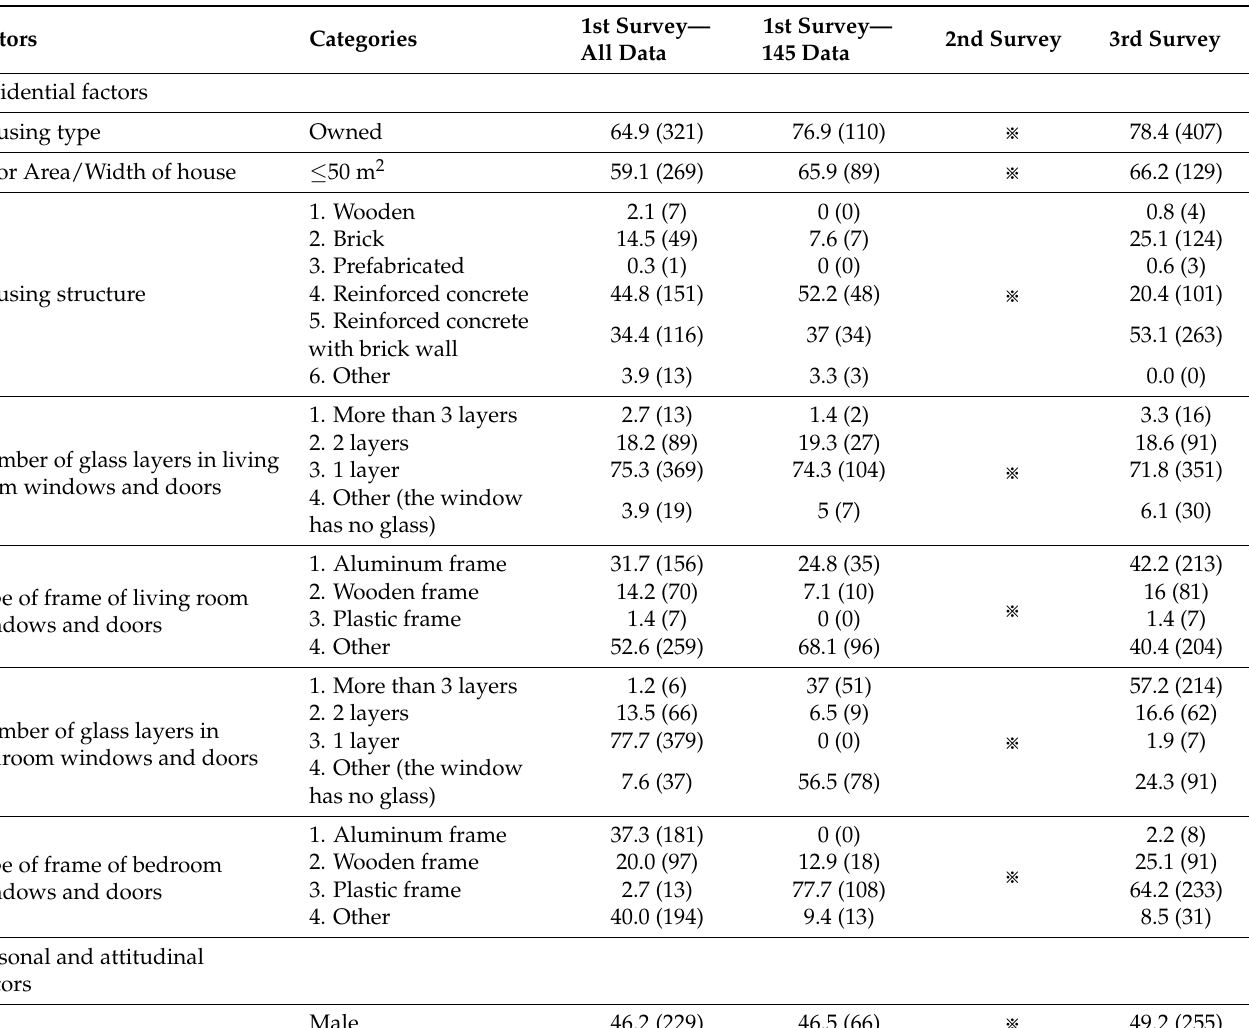
Table 9. Data on non-acoustic factors investigated in the surveys, including the proportion of respon- dents (in parentheses: number of responses) in each category, such as smoking status, employment status, and other health-related